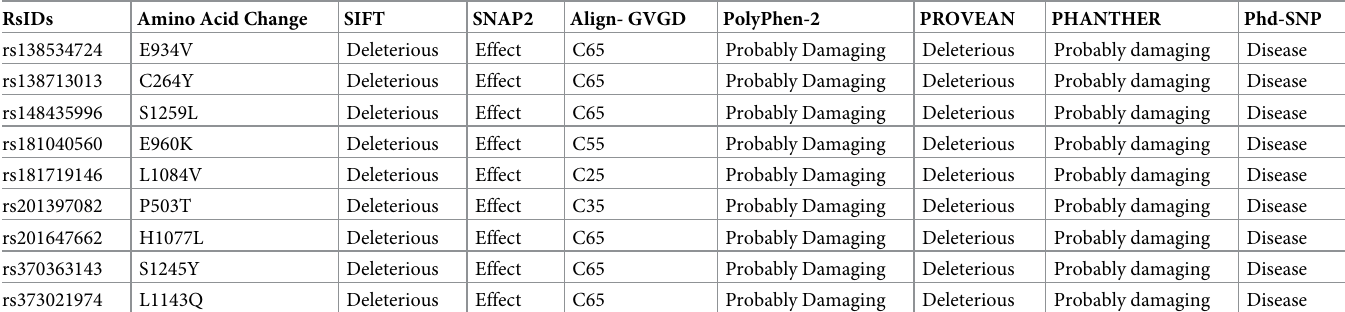
Table 1. Identification of deleterious nsSNPs by 7 in silico programs. RsIDs Amino Acid Change